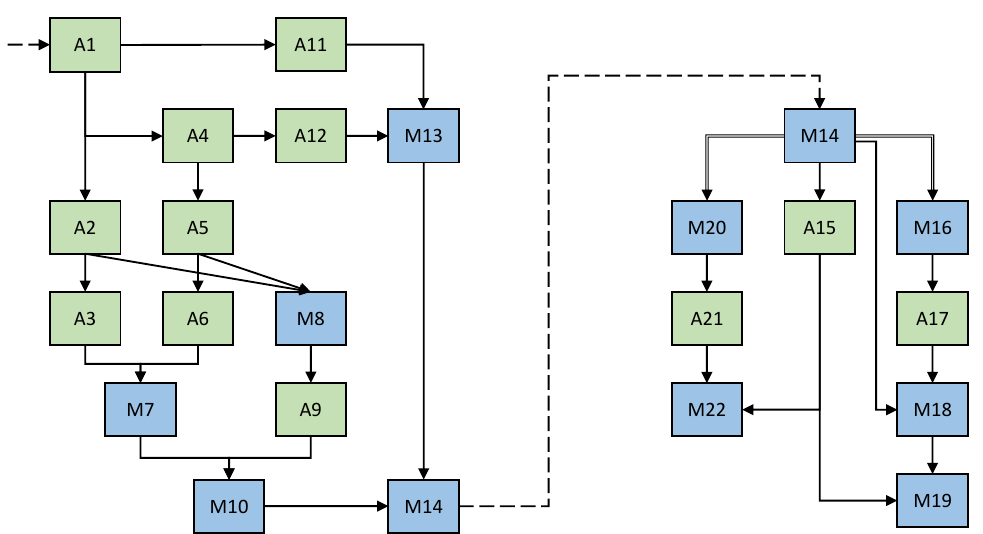
Figure 2. Pipeline illustration with transformation names from Table 1.